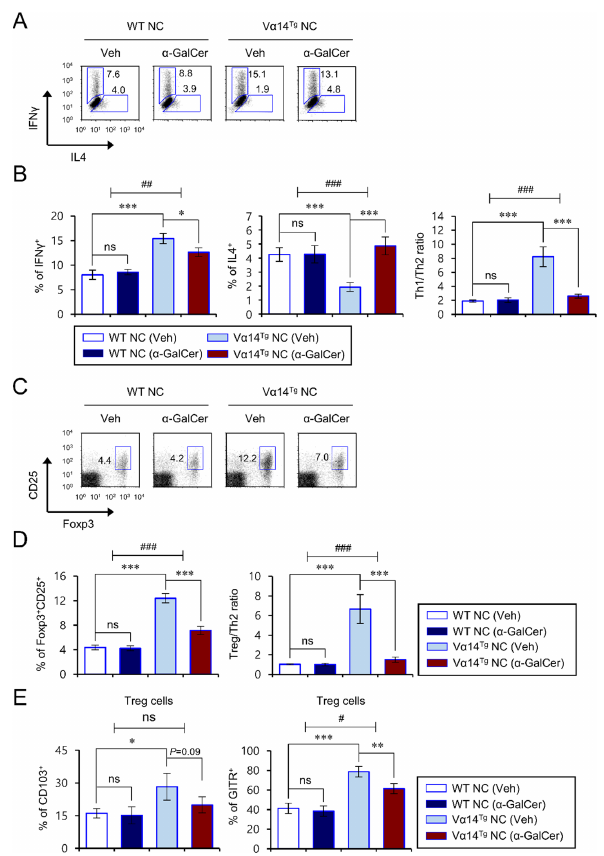
Figure 3. α -GalCer-mediated exacerbation of AD pathogenesis correlates with reduced Th1/Th2 cytokine ratios and Treg cells in V α 14 Tg NC mice. ( A – E ) Spleens were prepared from mice as shown in Figure 1. ( A,B ) IFN γ - and IL4-producing populations in splenic CD4 + T cells were determined by flow cytometry. ( C,D ) The percentage of Foxp3 + CD25 + cells among CD4 + T cells was evaluated by flow cytometry. ( A,C ) Representative FACS plots. ( B,D ) Summary of data. ( E ) Cell surface expression of CD103 and GITR on splenic Foxp3 + CD25 + Treg cells was analyzed by flow cytometry. The mean values ± SD ( n = 4 in A, B, C, D, and E; per group in the experiment; Student’s t -test; * p < 0.05, ** p < 0.01, *** p < 0.001) are shown. Two-way ANOVA (V α 14 TCR Tg × α -GalCer) showed an interaction between these two factors. One representative experiment of two experiments is shown ( # p < 0.05, ## p < 0.01 and ### p < 0.001).